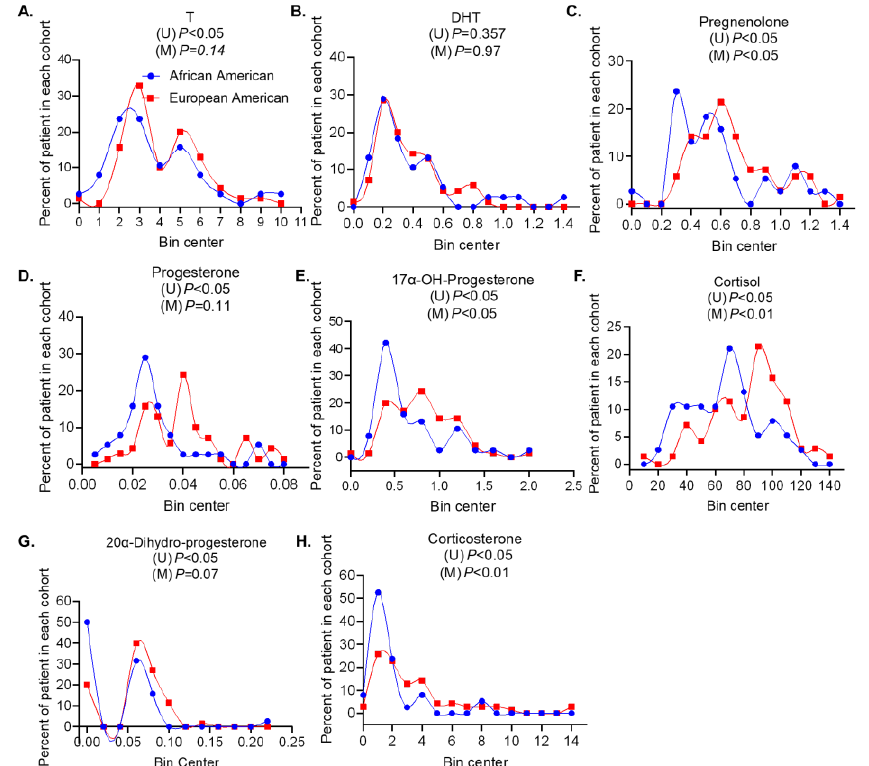
Figure 1. Serum distribution of testosterone (T), dihydrotestosterone (DHT), and intermediate metabolites in AA men and EA men. Differences in the serum metabolite levels between African American (AA) and European American (EA) men were compared using a left-censored version of the log-rank test in the univariate analysis. A multivariable Tobit regression model was used to compare metabolites between racial and Gleason groups while adjusting for confounders. ( A , B ) Distribution of serum androgen levels, T and DHT, in AA and EA men with prostate cancer. ( C – H ) Distribution of serum levels of intermediate metabolites produced during androgen biosynthesis in AA and EA men with prostate cancer. Blue lines represent the frequency of distribution of T and DHT levels in the serum of AA men and red lines represent the frequency of distribution of T and DHT levels in the serum of EA men. The p -value represents significant differences between AA and EA men from the univariate analysis (U) and multivariate analysis (M) that adjusts for age and grade. Table 1. Multivariate analysis of serum androgens and related metabolites of AA and EA men. Metabolite (Adjusted for Age and